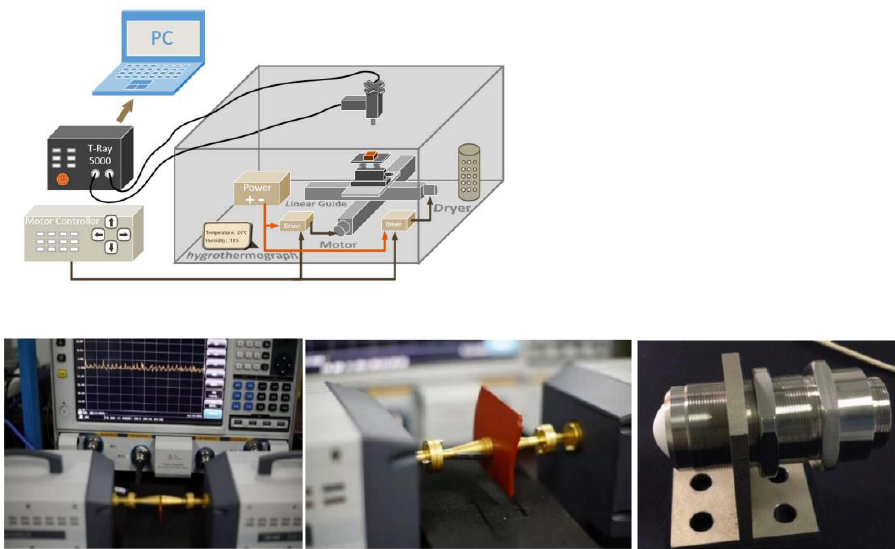
Figure 5. Terahertz detection experimental platform.